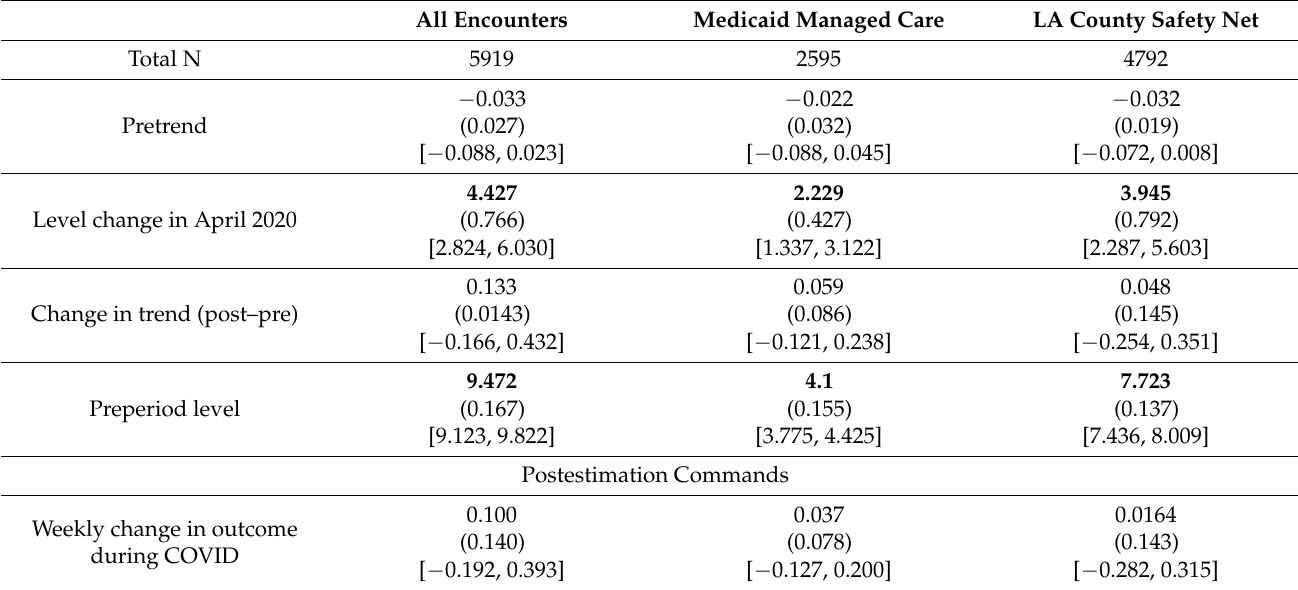
Table 3. Interrupted Time Series Results by Payor